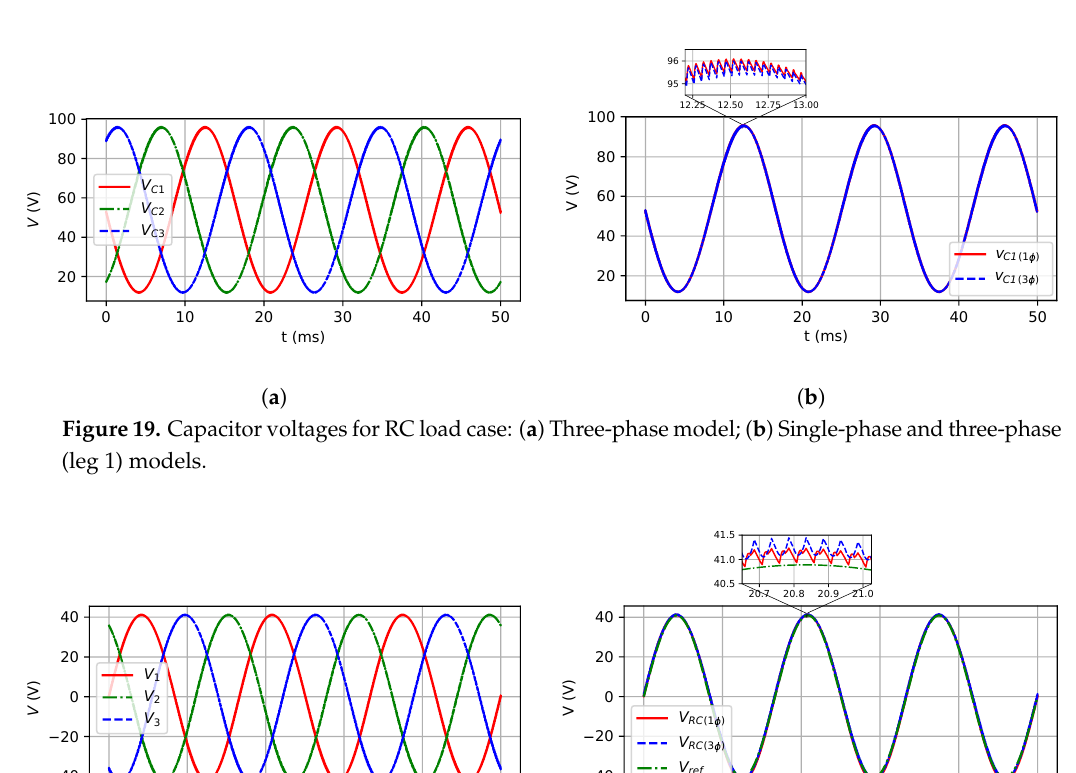
Figure 18. Inductor currents for RC load case: ( a ) Three-phase model; ( b ) Single-phase and three-phase (leg 1) models.